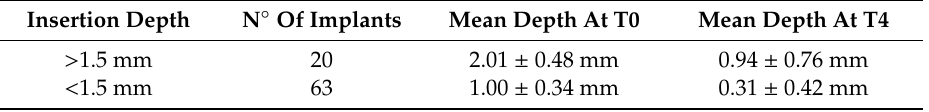
Table 5. Bone loss variations in groups with di ff erent implant insertion depth. Insertion Depth N ◦ Of